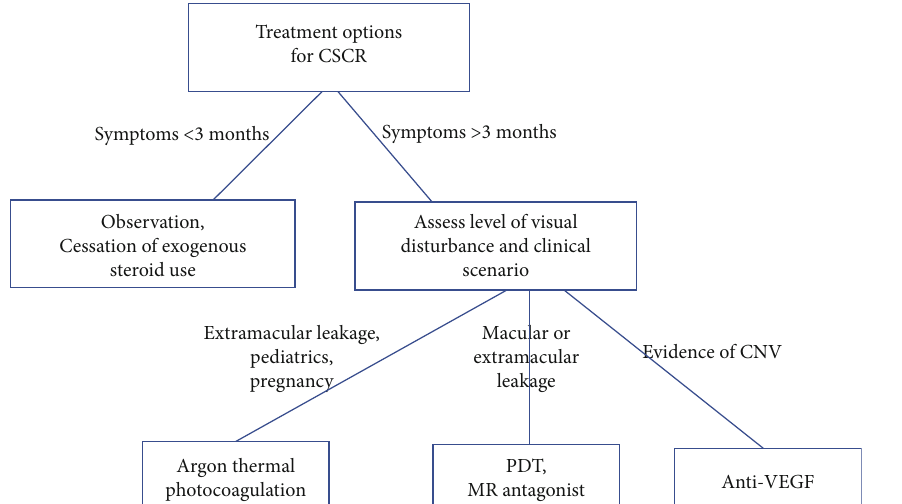
Figure 16: Review of treatment options in patients with central serous chorioretinopathy (CSCR). CNV: choroidal neovascularization; MR: mineralocorticoid; PDT: photodynamic therapy; VEGF: vascular endothelial growth